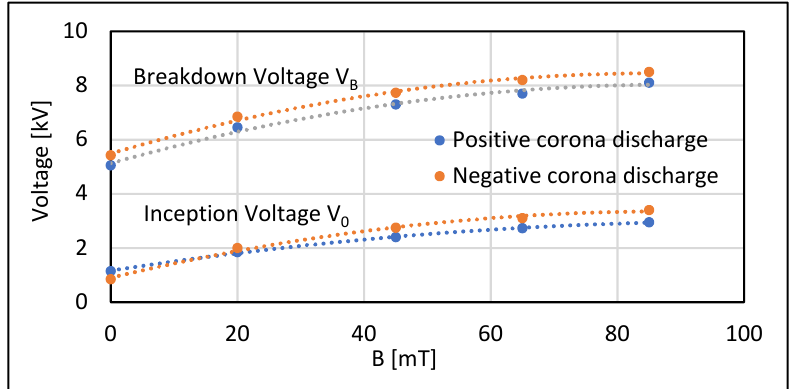
Figure 7. Corona inception and breakdown voltages against magnetic field B for both discharge polarities.